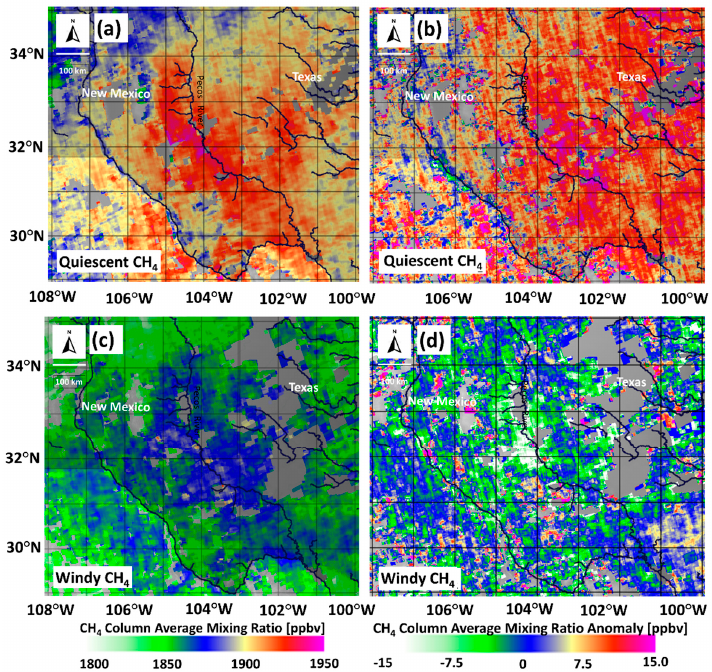
Figure 6. Average TROPOMI CH 4 column average mixing ratio (ppbv) for: ( a ) 24 September–9 October 2020 (quiescent) and ( c ) 1 April–10 May 2019 (windy); ( b ) difference (anomaly) between the “quasi-seasonal” CH 4 mean computed